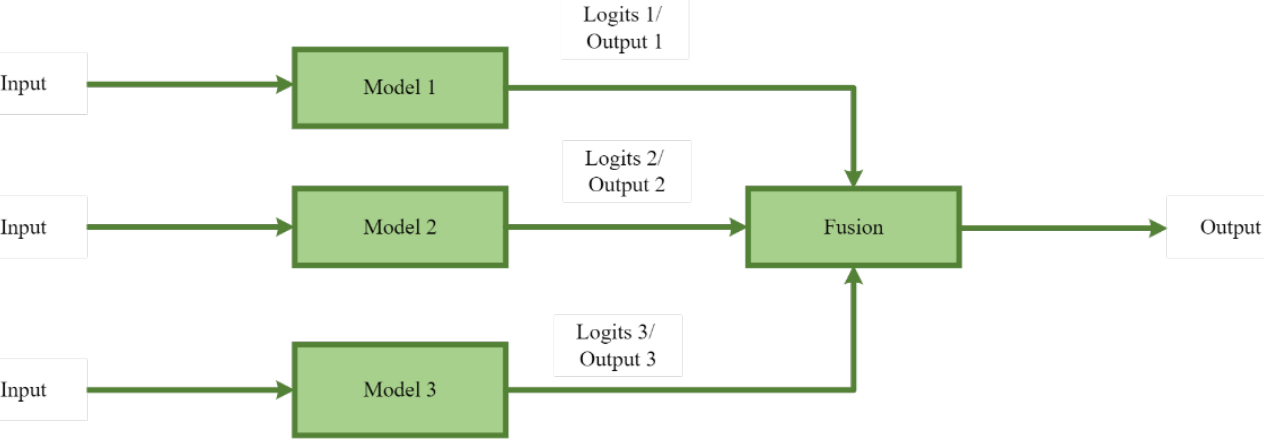
Figure 1. Decision fusion